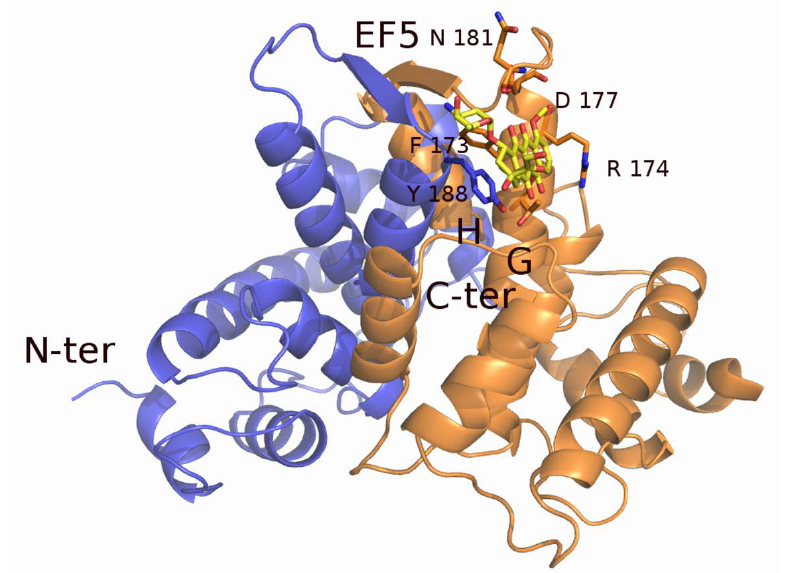
Figure 6. X-ray crystal structure of sorcin in complex with doxorubicin. The chemotherapeutic drug binds close to residues of the EF5 hand, interacting with residues of sorcin G- and H-helices. The two monomers of the sorcin dimer are colored blue and orange. The doxorubicin molecule (colored in yellow) and the residues interacting with it are represented as